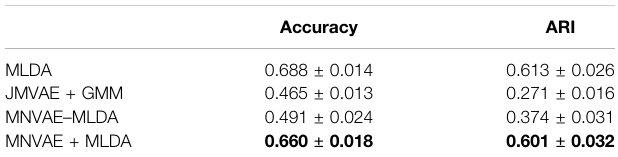
TABLE2| Classi fi cationaccuraciesandARIs. “ MLDA ” usedapre-trainedCNNfor the feature extraction, and is therefore considered as the performance upper